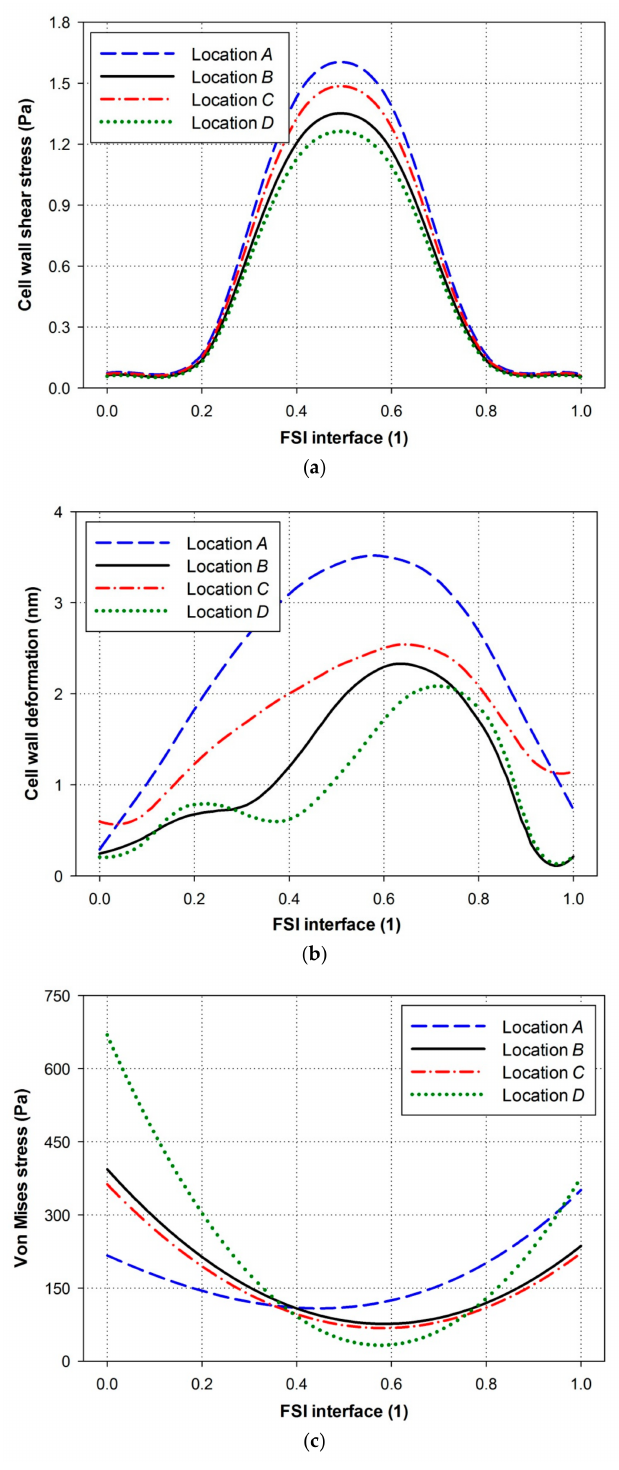
Figure 4. Effect of different locations of microalgal cells in the raceway pond on ( a ) cell wall shear stress (Pa); ( b ) wall deformation (nm); and ( c ) von Mises stress